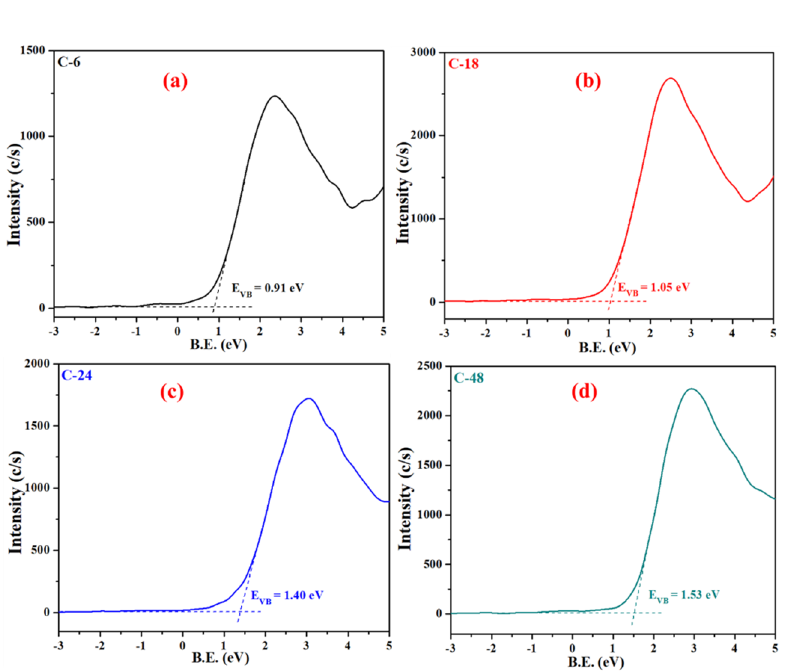
Figure 8. Valence band XPS spectra of CdS NRs prepared at different reaction times: ( a ) C-6, ( b ) C-18, ( c ) C-24, and ( d ) C-48.